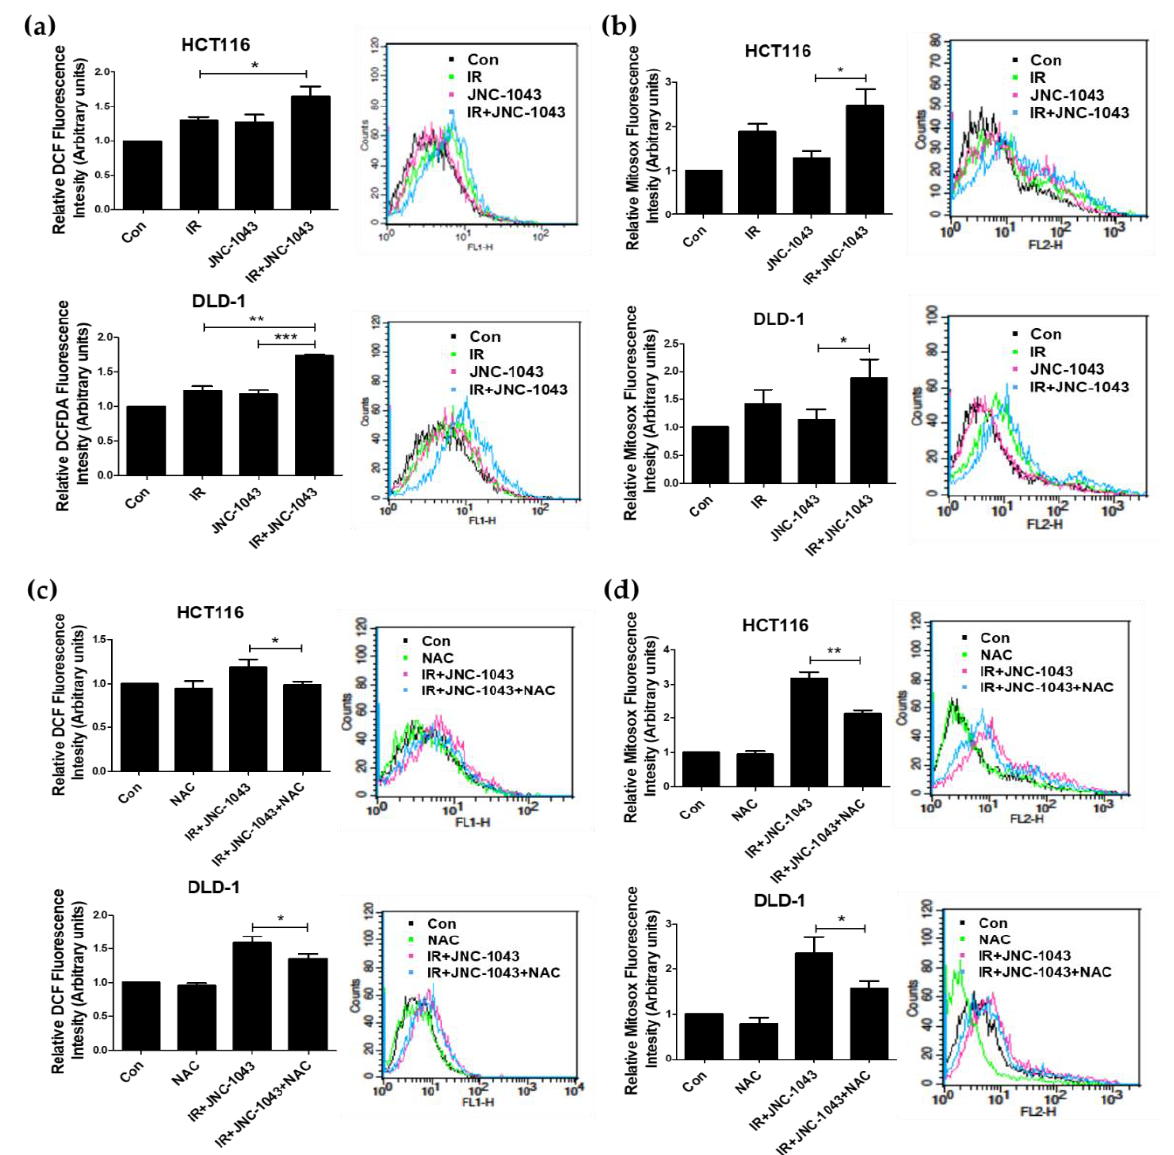
Figure 6. Co-treatment with JNC-1043 and IR leads to accumulation of mitochondrial ROS. ( a , b ) Detection of intracellular ROS ( a ), and mitochondrial ROS ( b ) using a FACSort flow cytometer. HCT116 and DLD-1 cells (5 × 10 5 ) were treated with or without 110 or 150 nM JNC-1043, respectively, exposed to 3 Gy IR, and incubated for 24 h prior to harvest. ‘Con’, mock control; ‘IR’, treatment with 3 Gy IR only; ‘JNC-1043 (cid:48) , treatment with 110 nM or 150 nM JNC-1043 only; ‘IR+JNC-1043 (cid:48) , combination of 3 Gy IR and 110 nM or 150 nM JNC-1043. Experiments were repeated in triplicate, and the presented results indicate the mean of triplicate assays. ( c , d ) Inhibition of ROS production by NAC. HCT116 and DLD-1 cells (2.5 × 10 5 ) were treated with or without 110 or 150 nM JNC-1043, respectively, exposed to 3 Gy IR, and incubated for 48 h prior to harvest. ‘Con’, mock control; ‘NAC’, HCT116 or DLD-1 cells pre-treated with 5 or 1 mM NAC, respectively; ‘IR+JNC-1043 (cid:48) , combination of 110 or 150 nM JNC-1043 with 3 Gy IR; ‘IR+JNC-1043+NAC’, combination of 3 Gy IR with 110 or 150 nM JNC in cells pre-treated with 5 or 1 mM NAC, respectively. Intracellular ROS ( c ) and mitochondrial ROS ( d ) were detected with a FACSort flow cytometer. Experiments were repeated in triplicate, and the results indicate the mean of triplicate assays. * p < 0.05, ** p < 0.01, *** p <